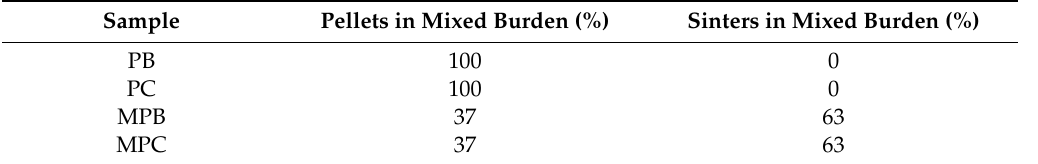
Table 2. Di ff erent burden composition used in the Table 2. Different burden composition used in the tests.